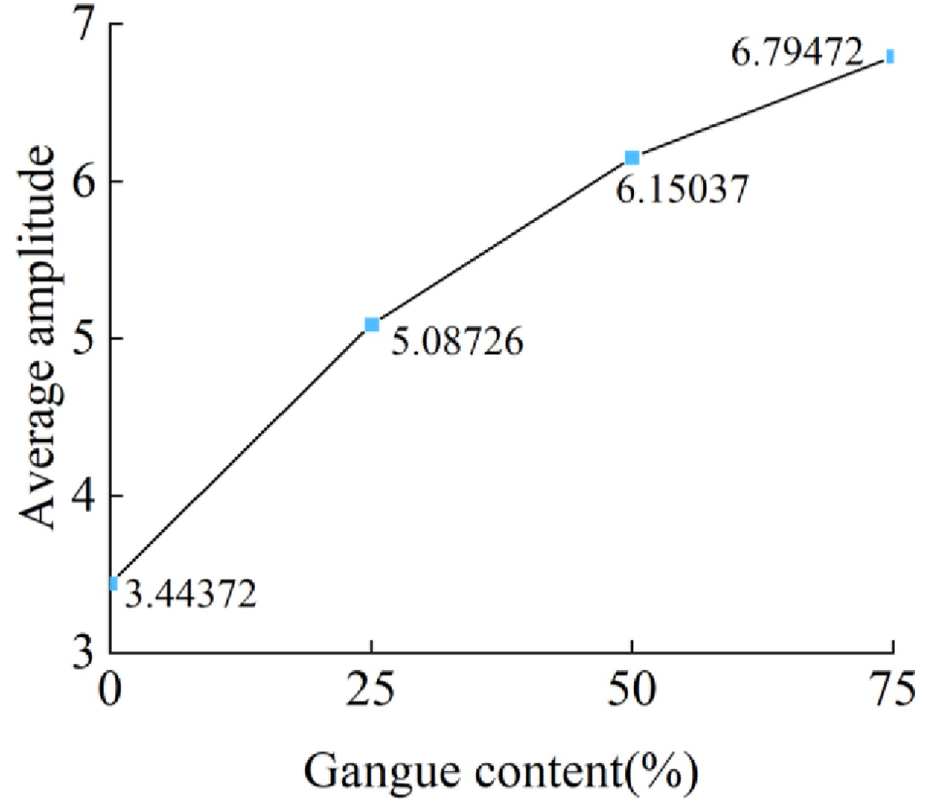
Fig 17. Gangue content versus the average value of the average amplitude.